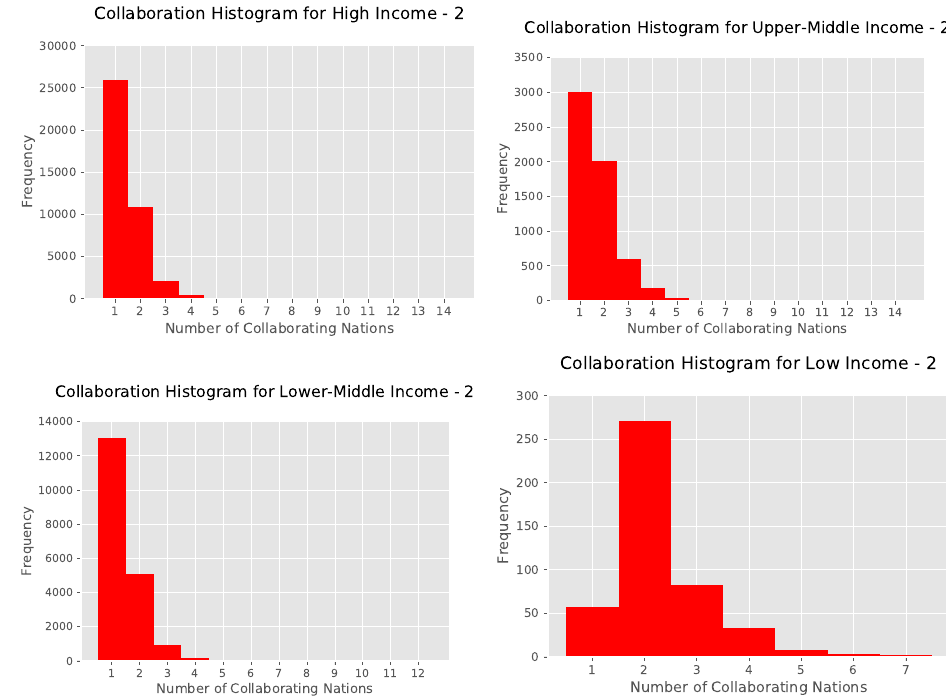
Figure 19. The distribution of distinct nations represented on papers in engineering and technology by income